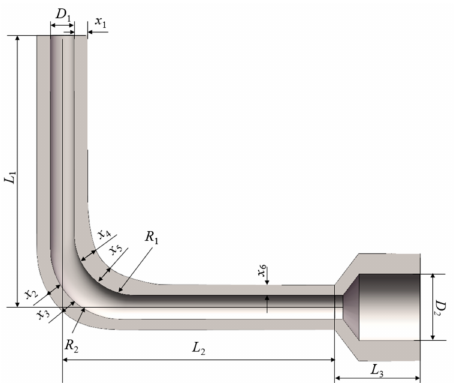
Figure 10. Solid domain of the hydraulic manifold with design variables.